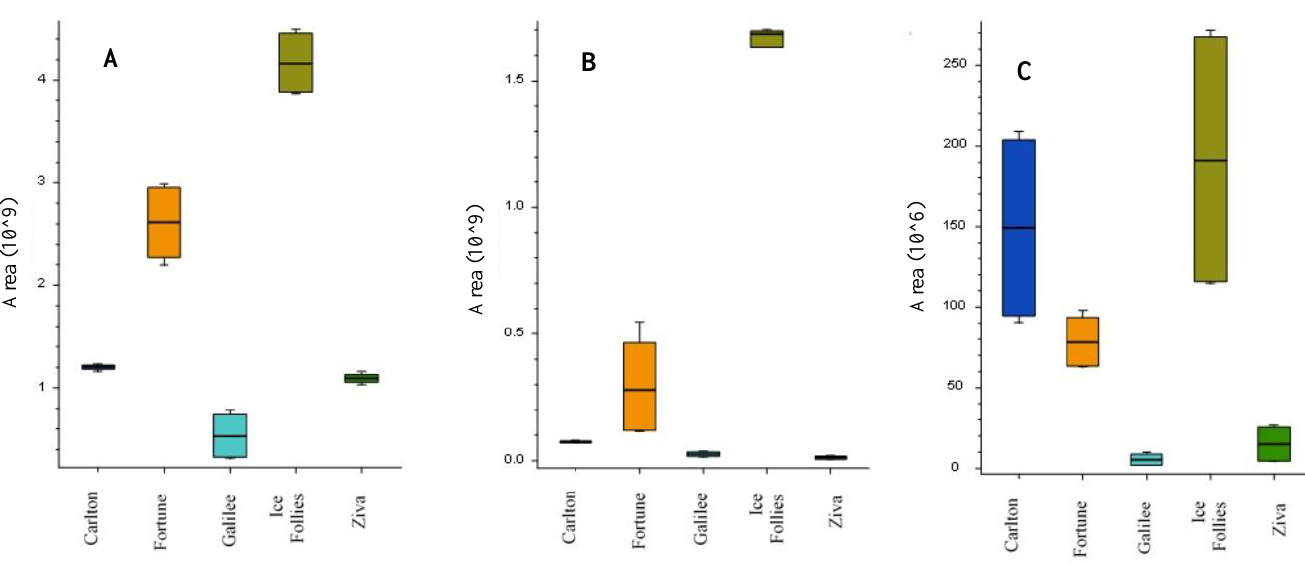
Figure 4. The distribution of the compounds carinatine ( A ), norgalantamine ( B ), galantamine ( C ), lycoramine ( D ), galan- thine ( E ), narweden ( F ) and narcissidine ( G ), detected mainly in the Carlton and Fortune cultivars presented as box plots. The figures present the mean area values obtained from four extracts for each cultivar ( n = 4), where the limit of the lower and upper quartile and the minimum and maximum of the distribution are presented as error bars.